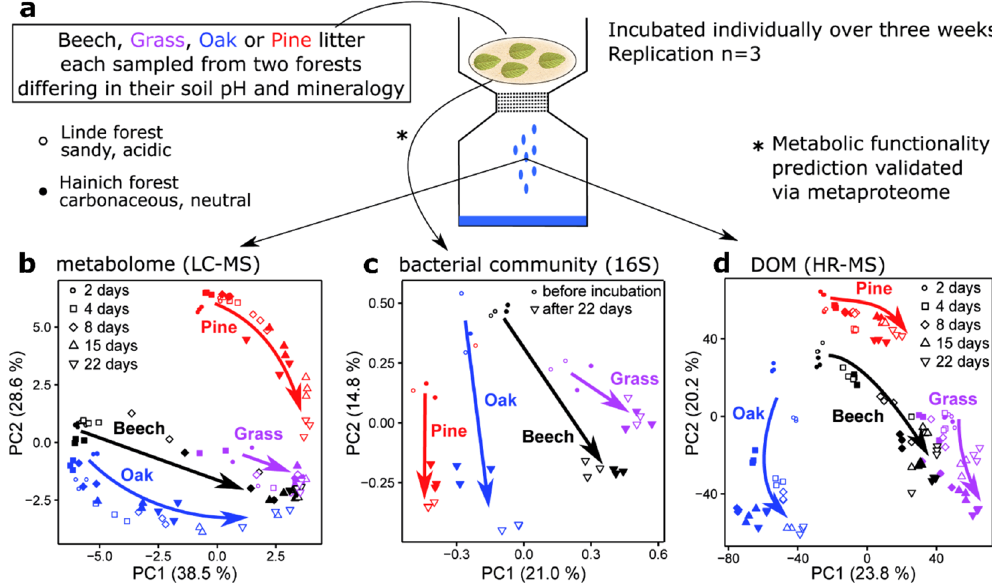
Figure 1. ( a ) Conceptual overview of the study design. ( b ) PCA of the LC–MS metabolome results indicates chemical convergence. ( c ) PCA of the 16S rRNA gene barcoding data indicates divergence and litter-specific community evolution. ( d ) PCA of the HR-MS data reveals a divergence between the tree-derived DOM, yet convergence between the beech and grass-derived DOM after ~ 8